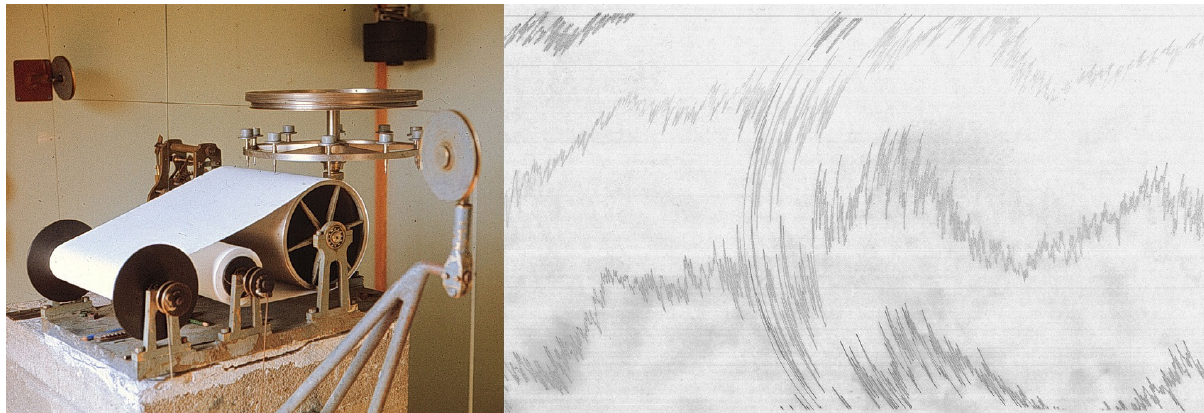
Figure 3. The Renqvist–Witting recording device used at most Finnish tide gauges from the 1920s to the early 1990s and an example of the paper charts recorded by the device at Hanko, showing a meteotsunami event on 9–10 May